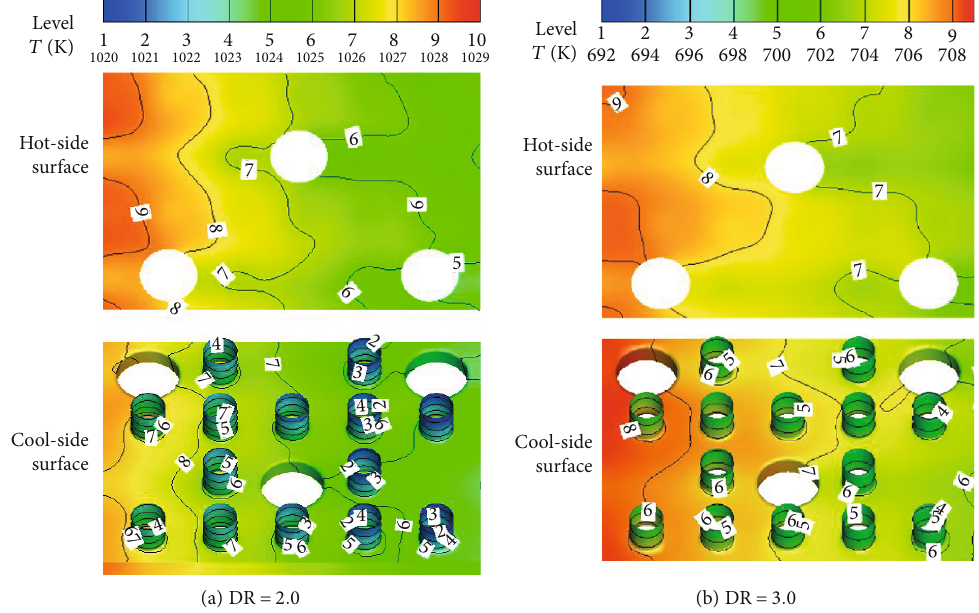
Figure 12: E ff ect of density ratio on temperature distribution on fi lm cooling plate.